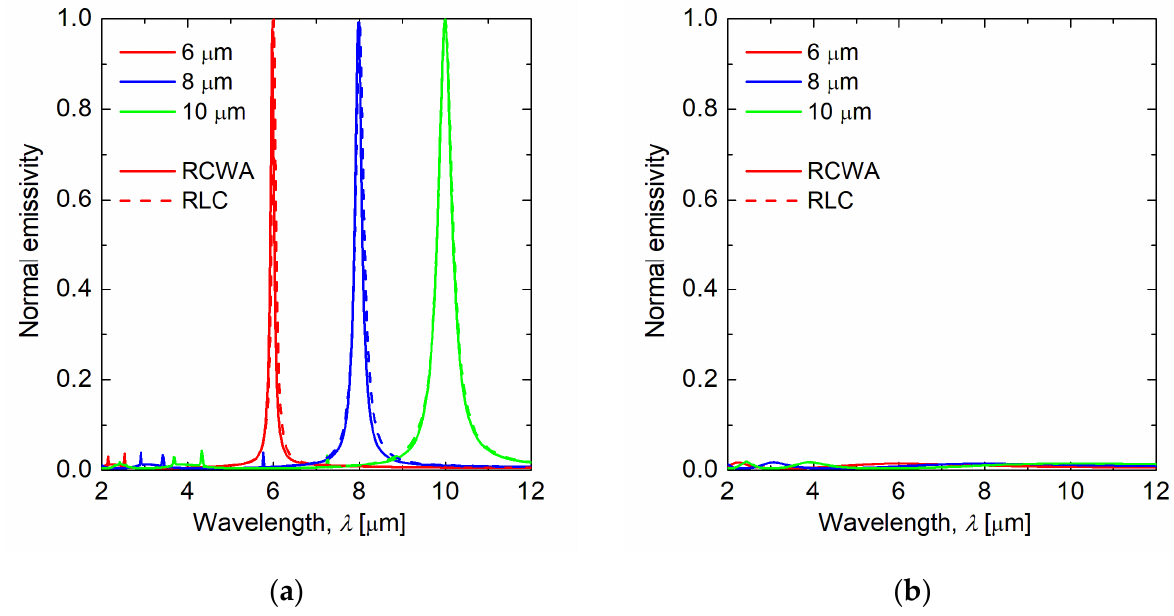
Figure 2. Normal emissivity spectrum for RCWA (colored solid line) and the equivalent circuit model circuit model (colored dashed line) of ( a ) switch-on state and ( b ) switch-off state. Target wavelengths are 6, 8, and 10 µm, and their Fermi energies of switch-on state are 1.64, 1.48, and 1.37 eV, respectively. Their Fermi energies of switch-off state are 0.01 eV.